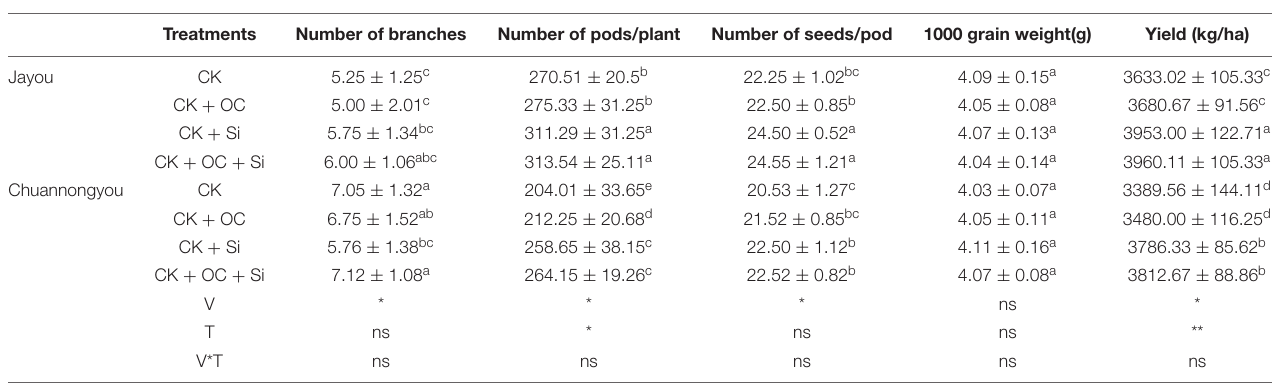
TABLE 6 | Effects of different fertilizer treatments on yield components.